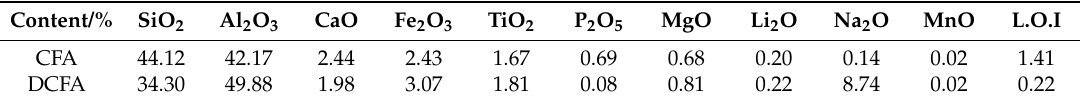
Table 1. Main chemical composition of CFA and the desiliconized coal fly ash (DCFA) samples (mass fraction, wt %). Abbreviation: L.O.I, loss of ignition.